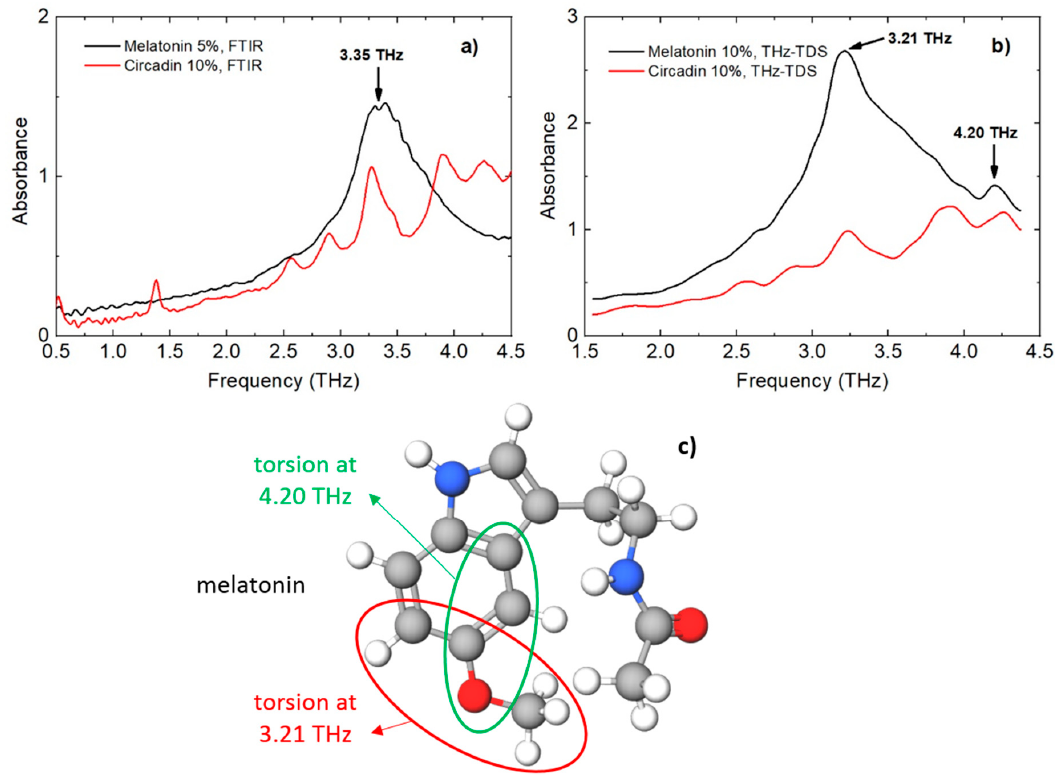
Figure 3. THz absorption spectra of melatonin and Circadin obtained by ( a ) FTIR and ( b ) THz-TDS. ( c ) Torsion modes of melatonin responsible for the spectral lines in the spectral region between 1.5 THz and 4.5 THz.